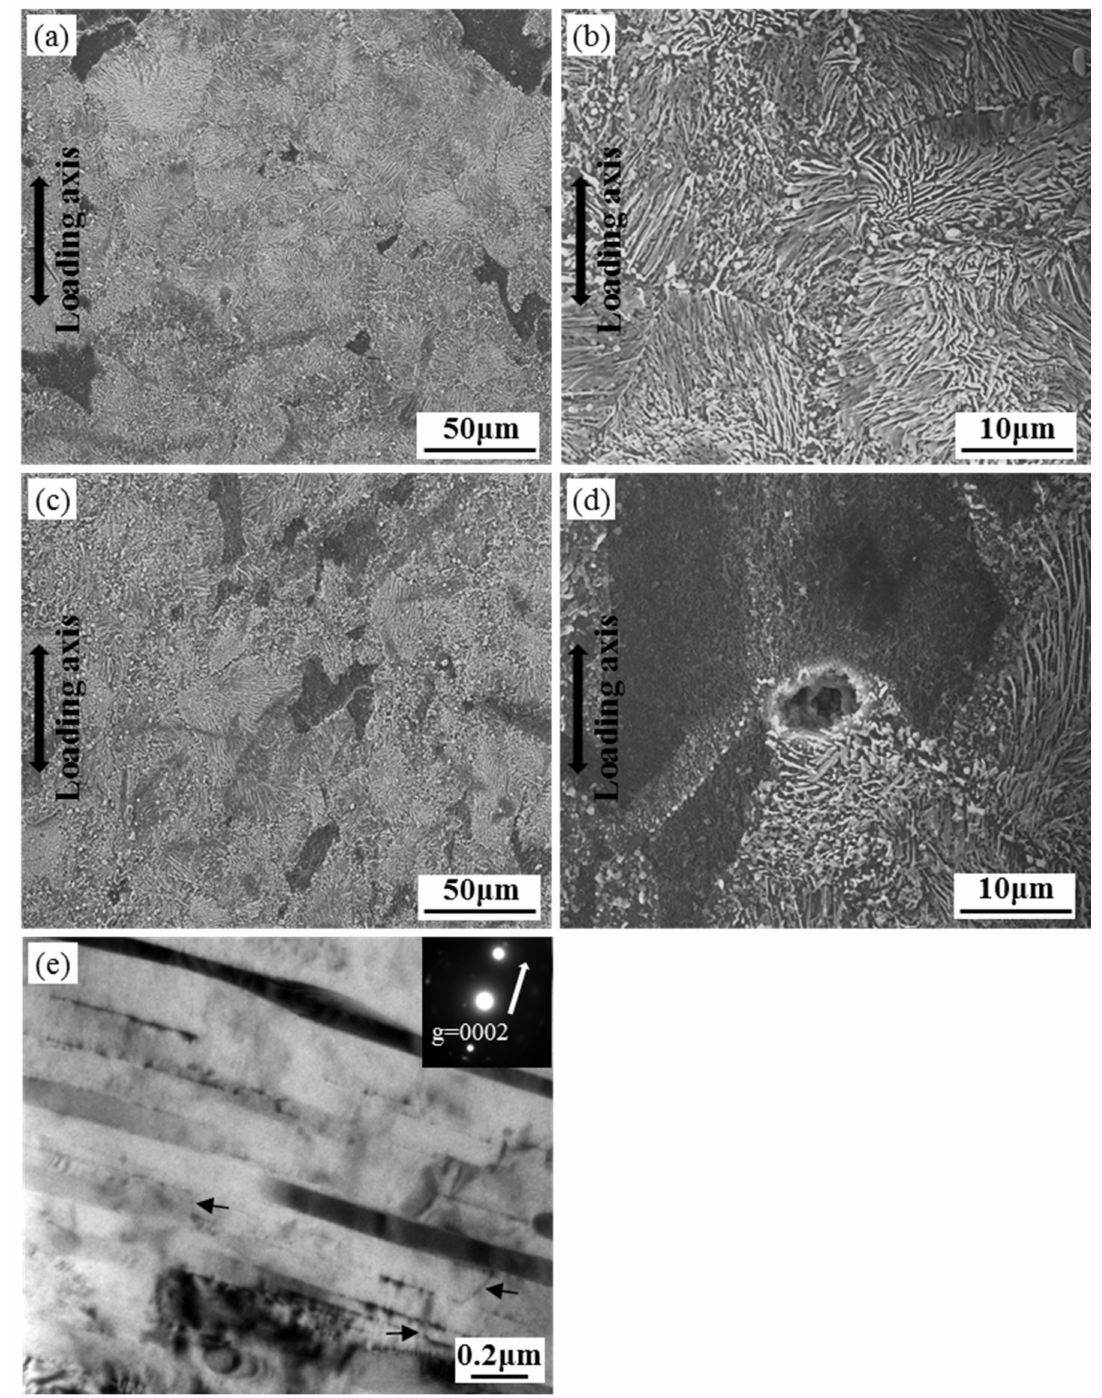
Figure 8. Microstructure of T5 specimens crept at ( a , b ) 150 ◦ C / 80 MPa and ( c – e ) 150 ◦ C / 90 MPa to 100